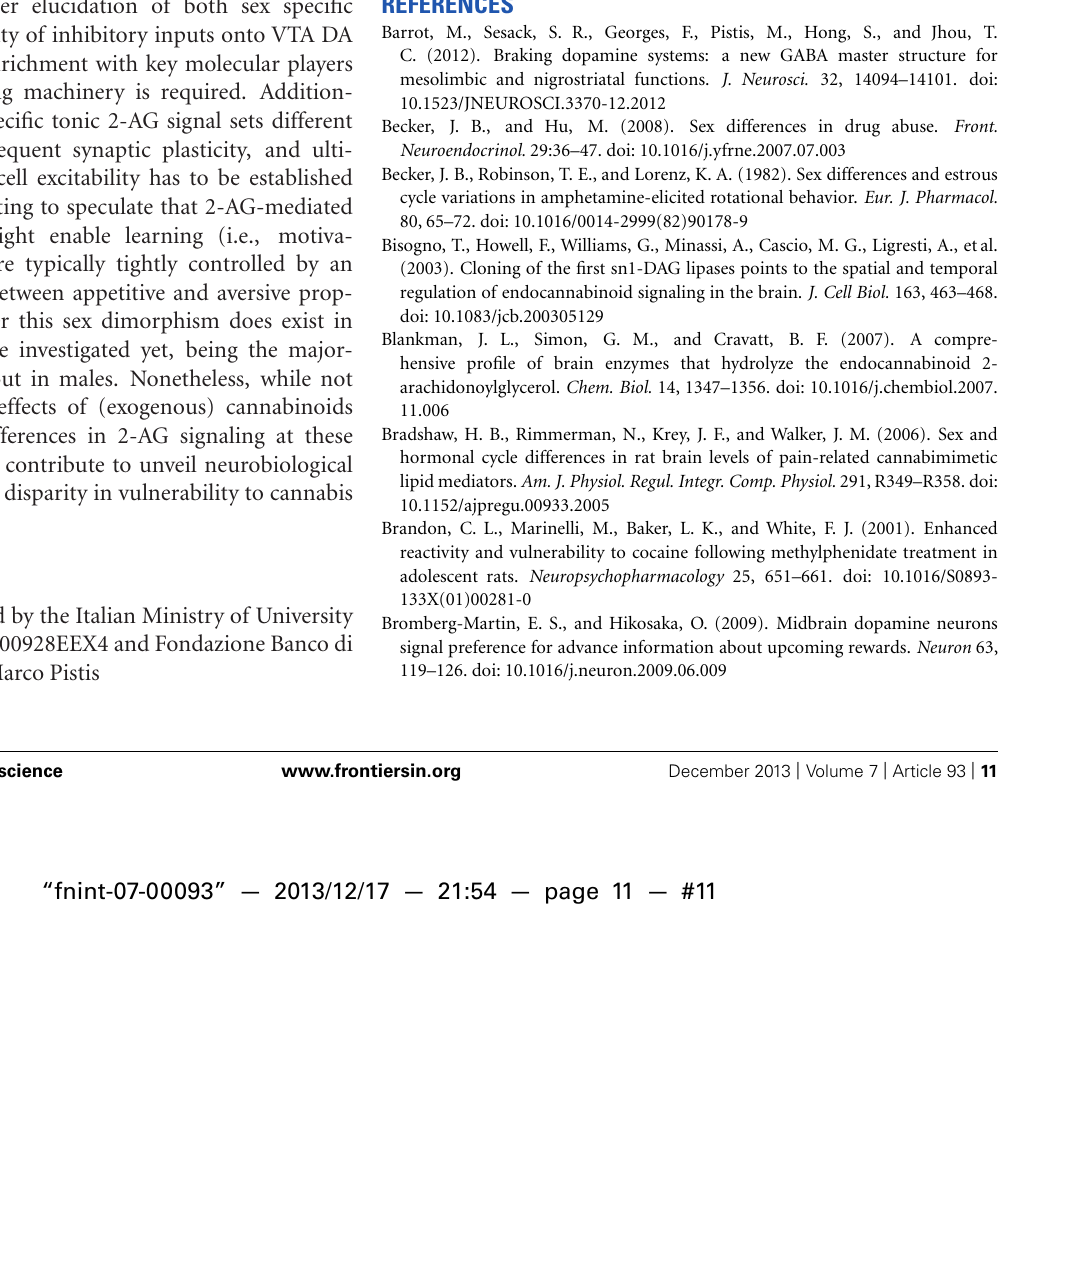
female LH rats from VTA DA cells and evoked by stimulating either rostral (left panel, n = 6 for both sexes) or caudal (right panel, n = 6 for both sexes) afferents, produced by WIN in the presence (gray squares) or absence (red circles) of JZL184. Each symbol represents the averaged value ( ± SEM) obtained from different cells. GABA A IPSCs amplitude was normalized to the averaged value (dotted line) before drug application. * P < 0.05, ** P <